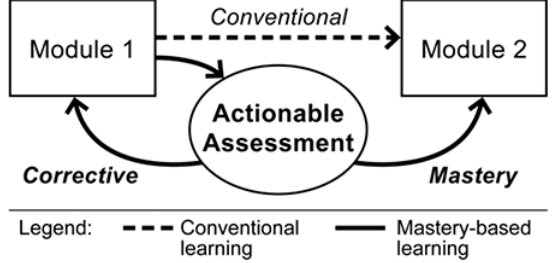
Figure 1 Personalised approach to learning, adapted from Guskey